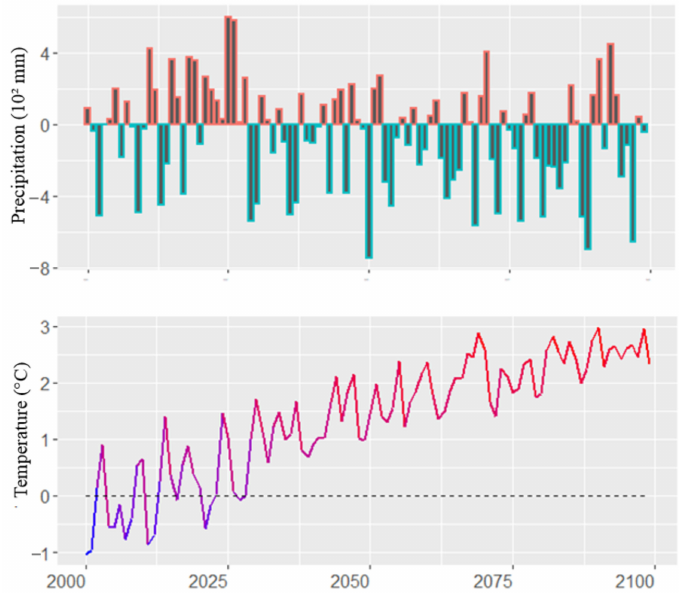
Figure 5. Temperature and precipitation anomalies regarding 2000–2019 period of the corrected CSS: Precipitation graph, the green color indicates deficit, and the red color indicates surplus concerning the period 2000-2019. Temperature graph, the blue color indicates temperatures below the average of the reference period and the red color indicates temperatures higher than the reference